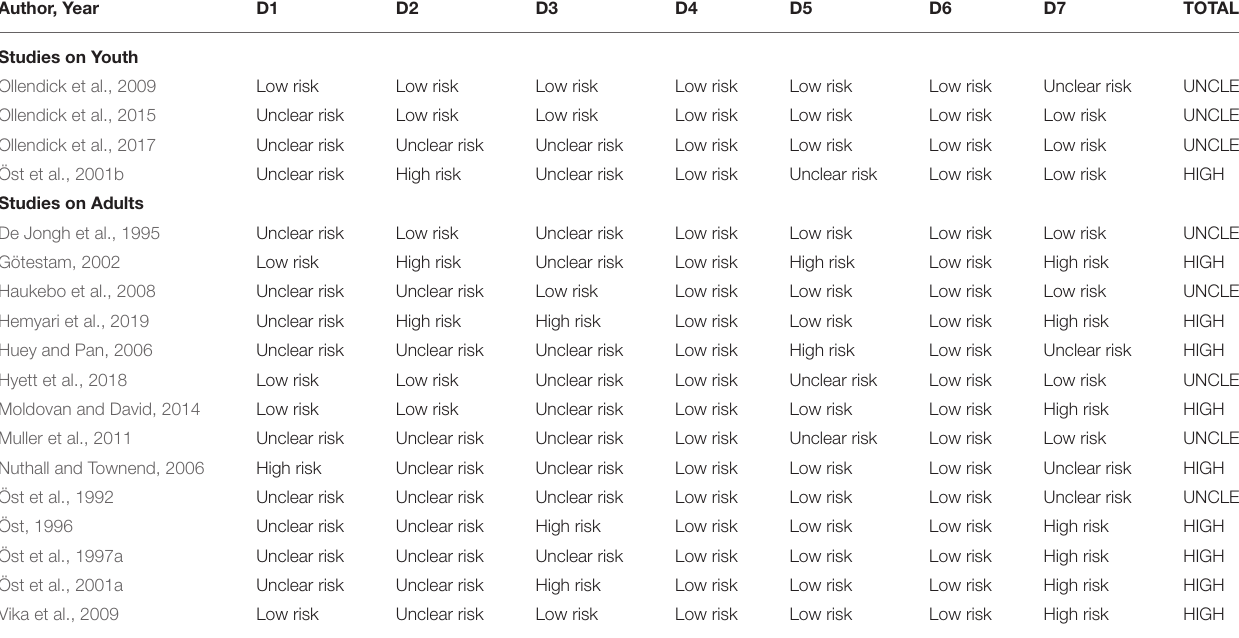
TABLE 2 | Quality assessing rating with Cochrane collaboration’s